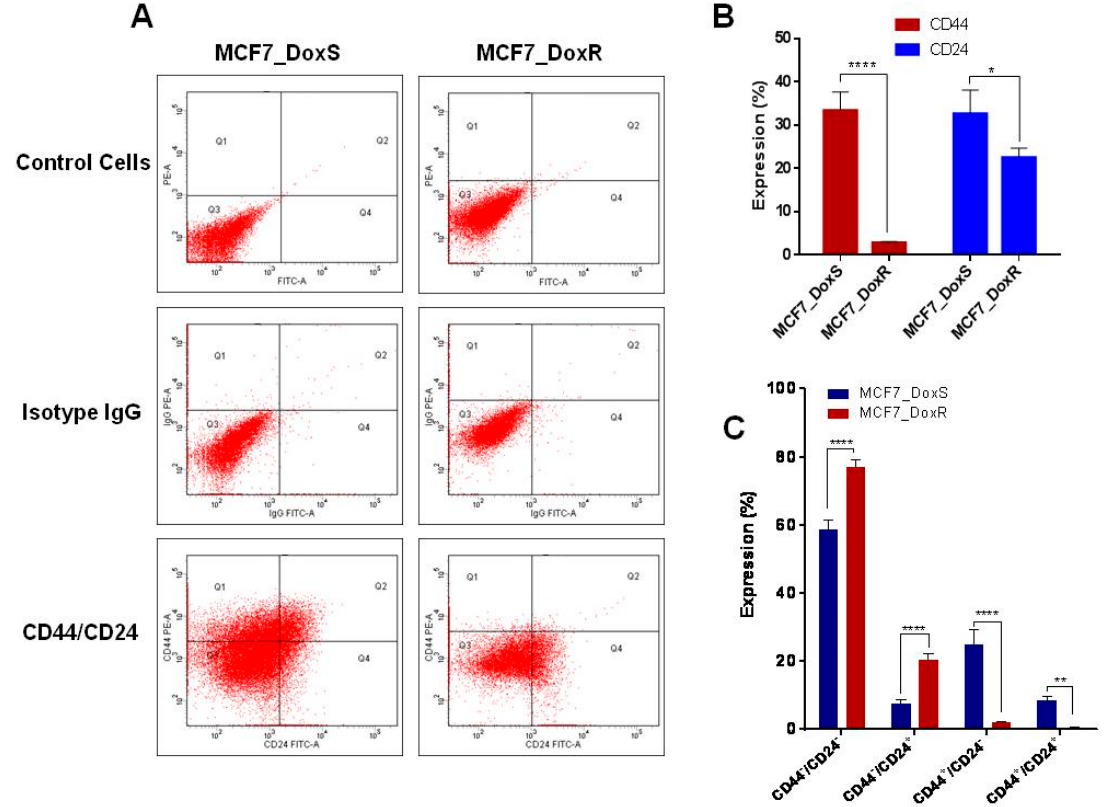
Int. J. Mol. Sci. 2019 , 20 , x FOR PEER REVIEW 9 of 18 Figure 4. Flow cytometric analysis for CD44 and CD24 expression by MCF7_DoxS control cells and the MCF7_DoxR cells. ( A ) Dot plot analysis for MCF7_DoxS and MCF7_DoxR cells labeled with anti-CD24-FITC and anti-CD44-PE. ( B ) The expression of individual CD44 and CD24. ( C ) The expression phenotype. The expression of markers was compared to their isotype controls. The data represent the average of three independent experiments ± SD. Statistical significance: Student’s t test, * indicates p < 0.05, ** indicates p < 0.01, **** indicates p < 0.0001.